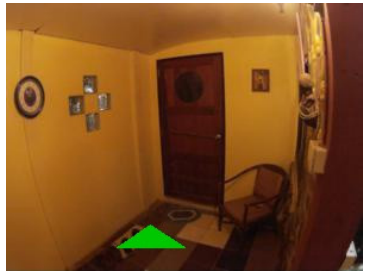
Figure 6. “Filled triangle”.